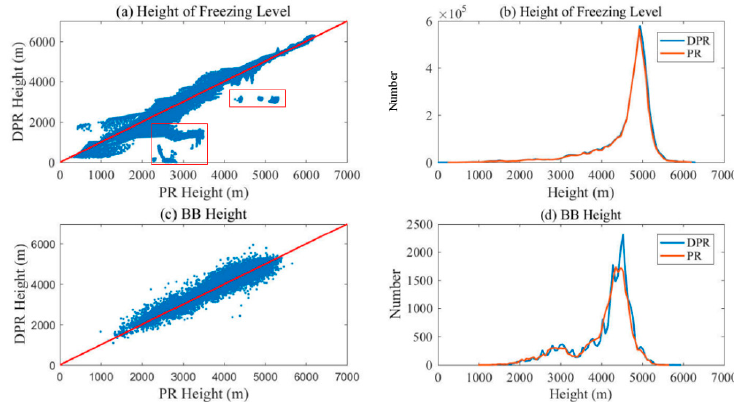
Figure 10. ( a ) Scatter plot; and ( b ) frequency distributions for freezing height level; and ( c ) scatter plot; and ( d ) frequency distributions for BB height. All figures are based on the coincident events of GPM DPR and TRMM PR. The red lines in ( a , c ) indicate where y equals x. After eliminating these pixels, the r was improved from 0.997 to 0.998. By calculating the difference of the freezing level height between the two radars and analyzing its global distribution, we found that GPM DPR tends to underestimate the freezing level height by approximately 100 to 400 m. During the studied time period, the average height of freezing level globally was 4378 m for GPM DPR and 4367 m for TRMM PR. The estimation of BB heights was closely related to the freezing level heights, the former generally appearing about 0.5 km below the latter, based on empirical evidence [40,73]. Therefore, the BB height derived from GPM DPR observations is slightly lower than that from TRMM PR. Special attention should be paid to the phenomenon that appears in the frequency distribution curves of the BB heights, in which both radars’ observations have two peaks. One was around 4.5 km and the other near 3 km. However, this is inconsistent with the tendency shown in the frequency distribution curves of the freezing level, which are unimodal curves with the same peak value of 5 km. The pixels with BB heights around 3 km given by GPM DPR, distributed randomly over the ocean, making it difficult to find a clear regularity. Pixels with BB height around 3 km given by TRMM PR, were predominately located near 37°N/S over the ocean. At the pixels where GPM DPR